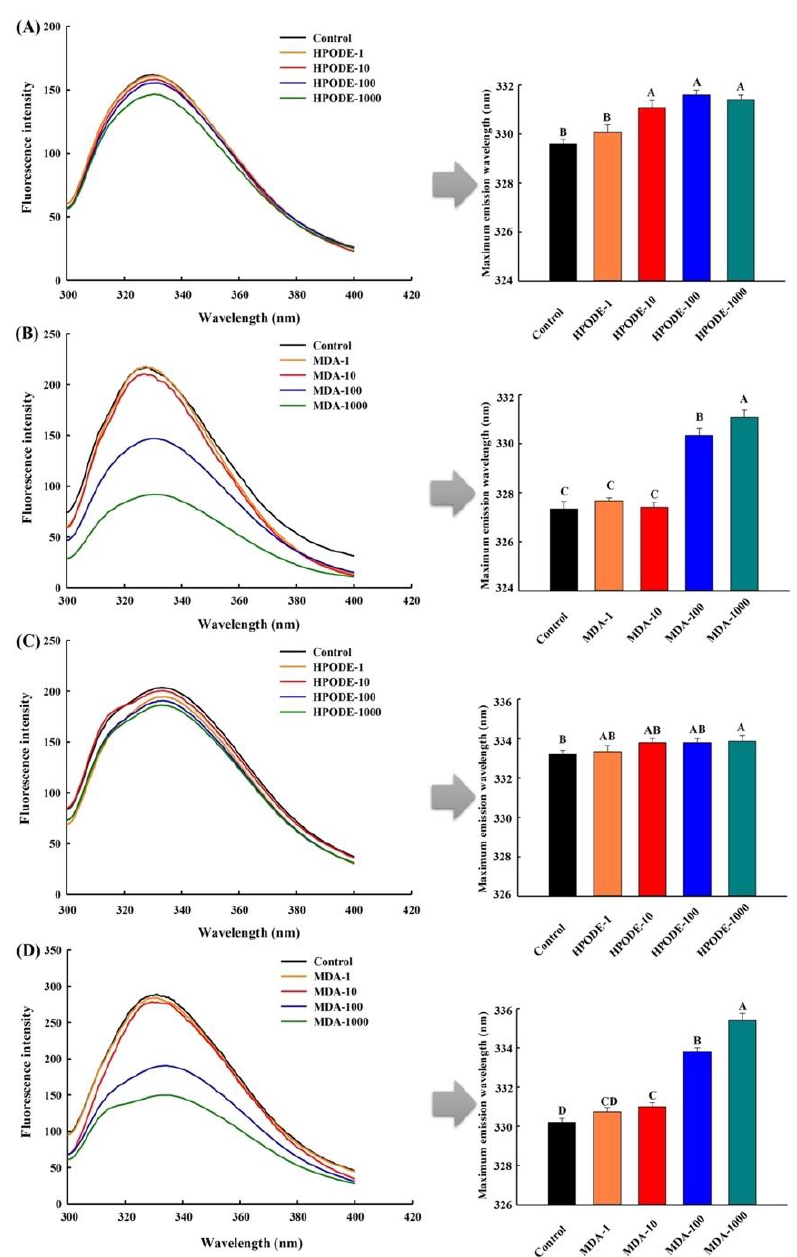
Figure 1. Intrinsic tryptophan fluorescence of the unadsorbed ( A , B ) and adsorbed proteins ( C , D ) extracted from O/W emulsions oxidized by different levels of HPODE and MDA (0, 1, 10, 100, and 1000 μmol/L emulsion) after 24 h incubation. Corresponding maximum emission wavelengths are shown in the right side.